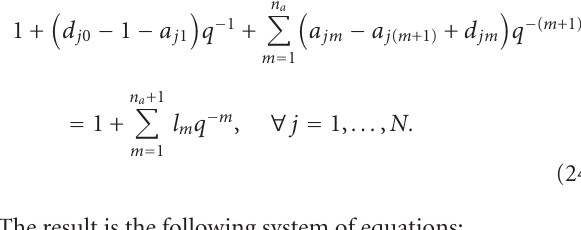
Figure 10: Practical results: outside temperature (blue line) and inside temperature (black line).